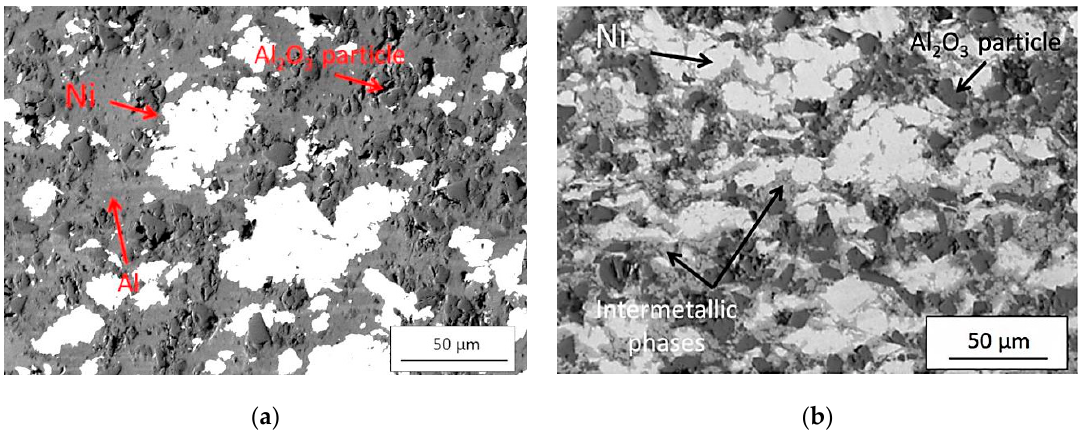
Figure 7. Micrographs (SEM, BSE) of 16% Al coating heated by resistance spot welding process with parameters No. 3 ( a ) and No. 4 ( b ).